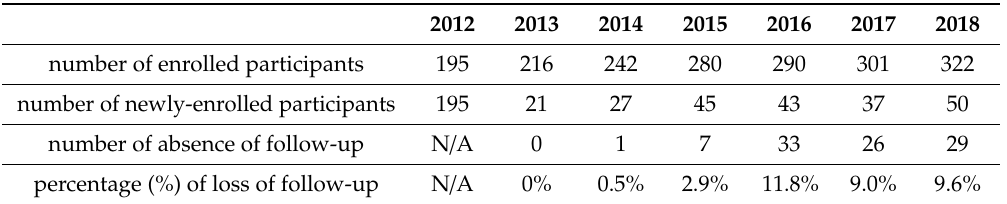
Table 1. Participant enrollment and loss of follow-up from 2012 to 2018.